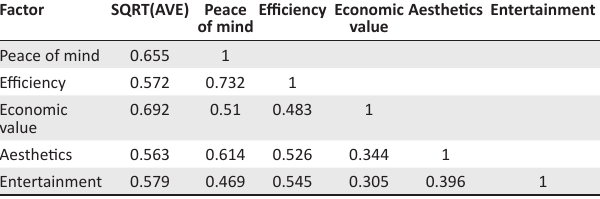
TABLE 3: Discriminant validity.